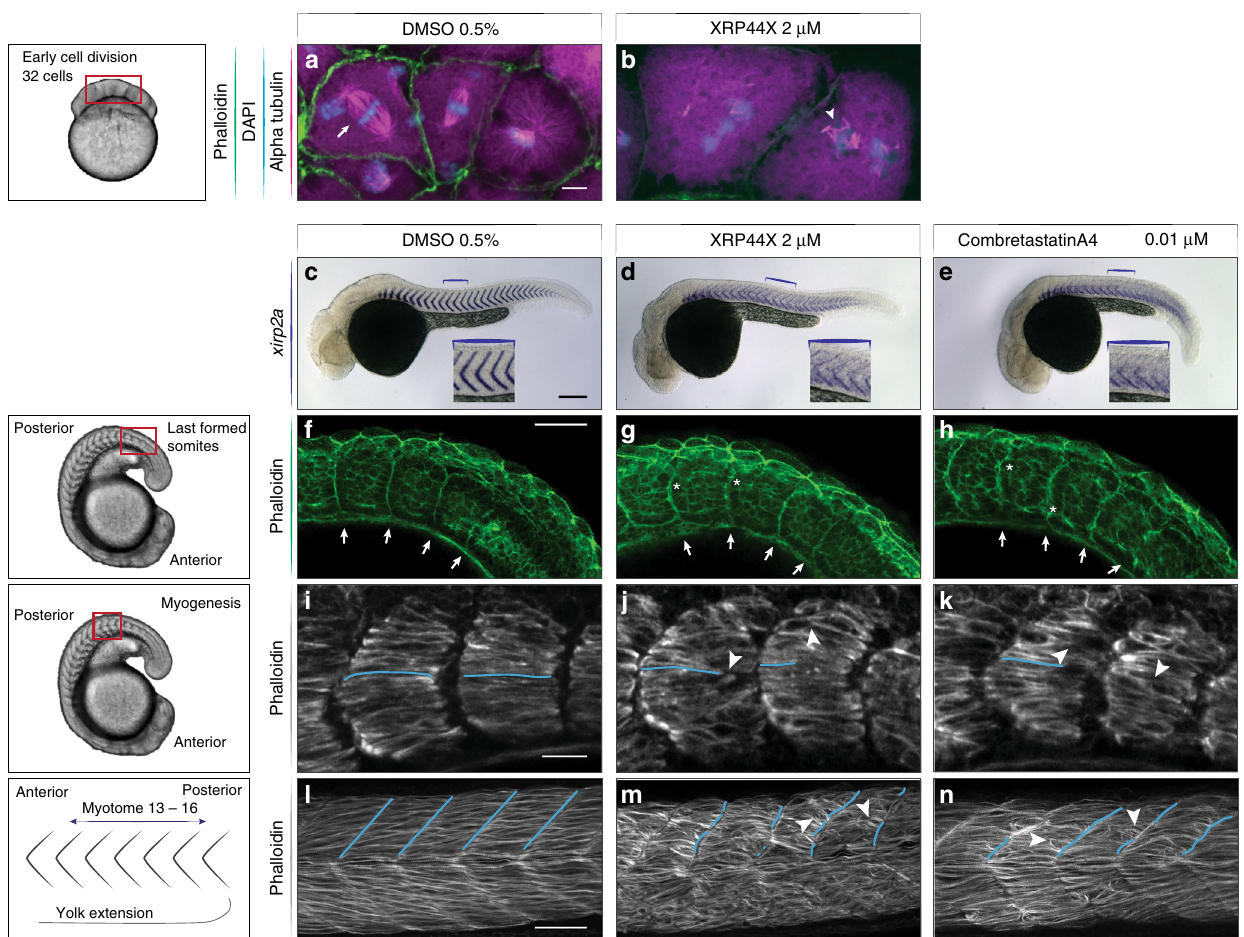
Fig. 6 Activity of XRP44X on microtubules during zebra fi sh segmentation. a , b Zebra fi sh blastomere cleavage at the 32 cell stage, F-actin in green (phalloidin), alpha tubulin in magenta and DNA with DAPI. a DMSO control, normal division with mitotic spindles (arrow). b XRP44X treated embryos, short microtubules, no mitotic spindle (arrowhead). Scale bar = 10 µ m. c – e Embryos at 36 hpf, showing DMSO control, 2 µ M XRP44X and 0.01 µ M combretastatin A4 treatment. Xirp2a mRNA shows myotome boundaries with chevron pattern in DMSO ( c ; inset), ectopic xirp2a staining between faint and blurry boundaries with small molecule treatments ( d , e ; inset). f – h F-actin (phalloidin, green) in 20 ss embryos showing most recently formed boundaries (arrows). f In DMSO, thin straight boundary lines form between somites. With XRP44X g and combretastatin A4 h treatments, boundaries formed less clearly, and mature boundaries had gaps (asterisks). i – k During myogenesis, muscle fi bers elongate (blue lines) to span the myotome i . With XRP44X and combretastatin A4, muscle fi bers do not fully span the myotome j , k remaining partly rounded (arrowheads). l , m Myotomes of DMSO control and small molecule-treated embryos at 36 hpf. F-actin visualized with phalloidin (gray). Muscle fi bers are well organized within each myotome in DMSO l , vertical myotome boundaries are highlighted as blue lines. m , n Small molecule-treated embryos showed loss of muscle fi ber structure with round and short muscle fi bers (arrowheads) and no clear myotome separation. XRP44X m treatment showed a higher level of disorganization than combretastatin A4 n . c – h , l – n scale bar = 50 µ m, i – k scale bar = 20 µ m. N = 30, 3 of 3 experiments showed representative